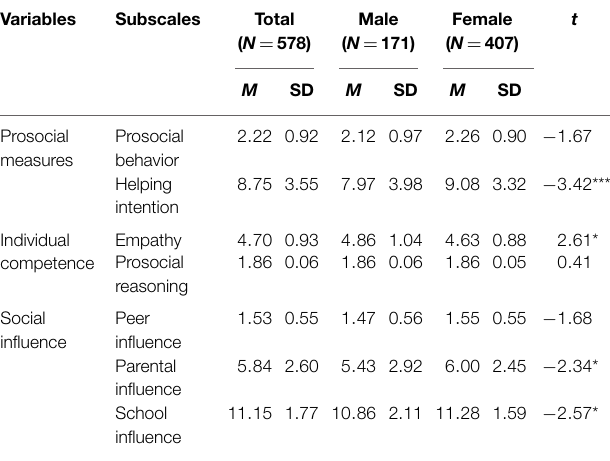
TABLE 2 | Correlations between potential predictor variables and prosocial behavior and helping intention . Correlates Prosocial